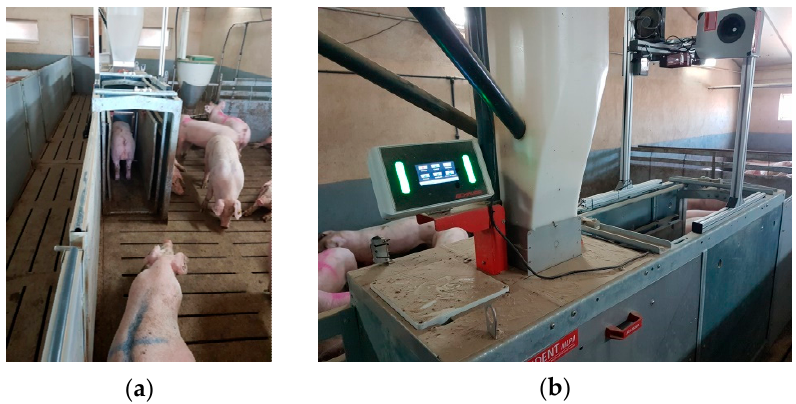
Figure 1. ( a ) Weighing scale and ( b ) feeding station used during the test.